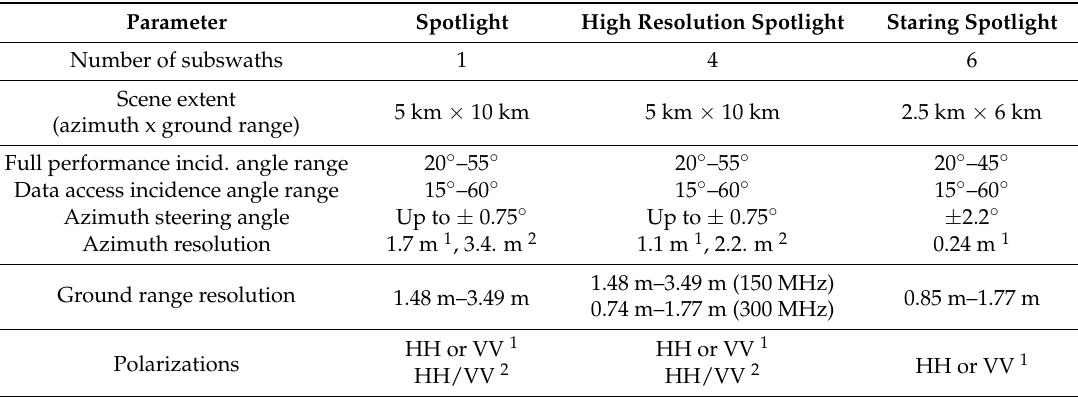
Table 2. TerraSAR-X Spotlight mode parameters (modified from